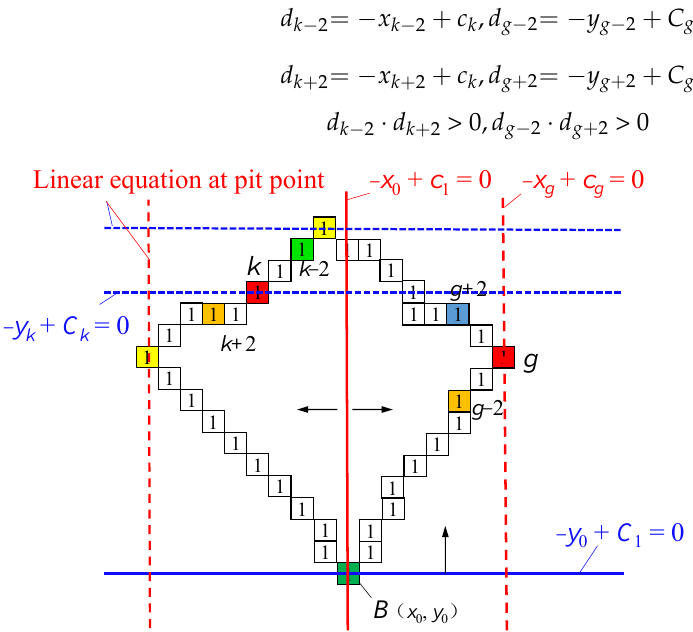
Figure 8. Principle of closed ‐ loop crossover algorithm (CLCA).